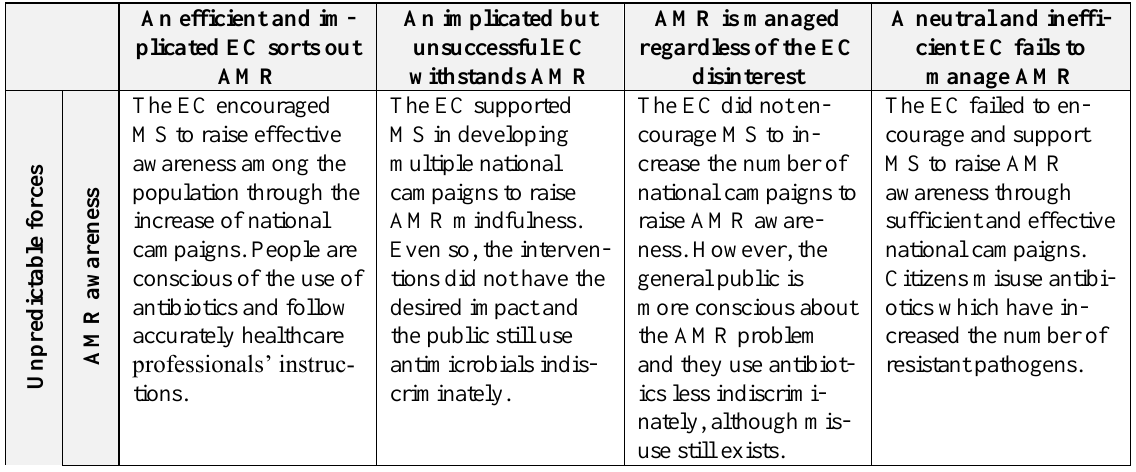
Table 2. Scenario planning for AMR in view of the